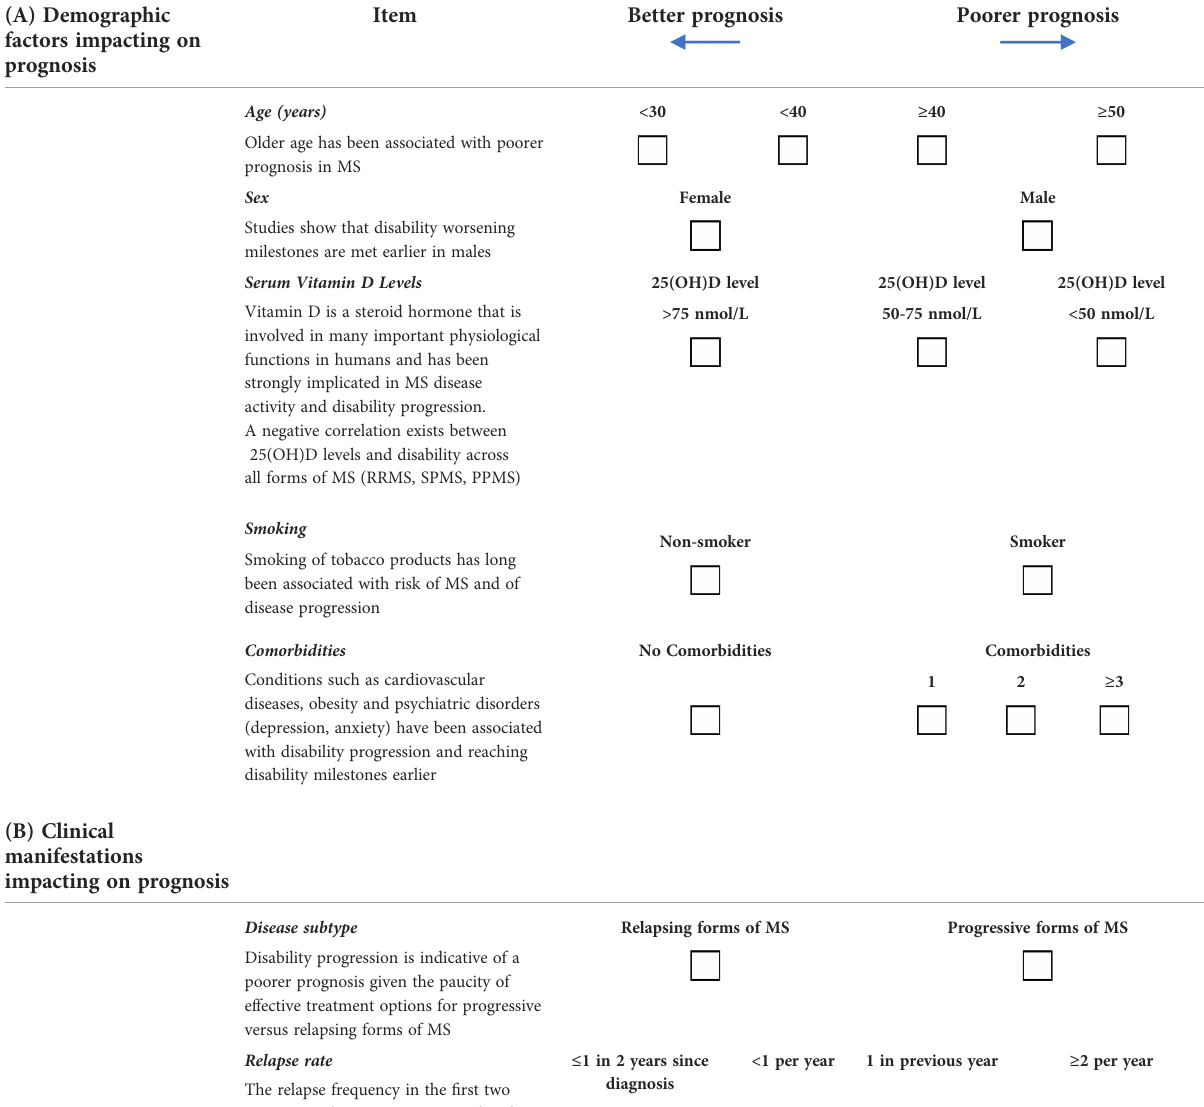
TABLE 1 Practical checklist for using personalized prognosis in MS. (A) Demographic factors impacting